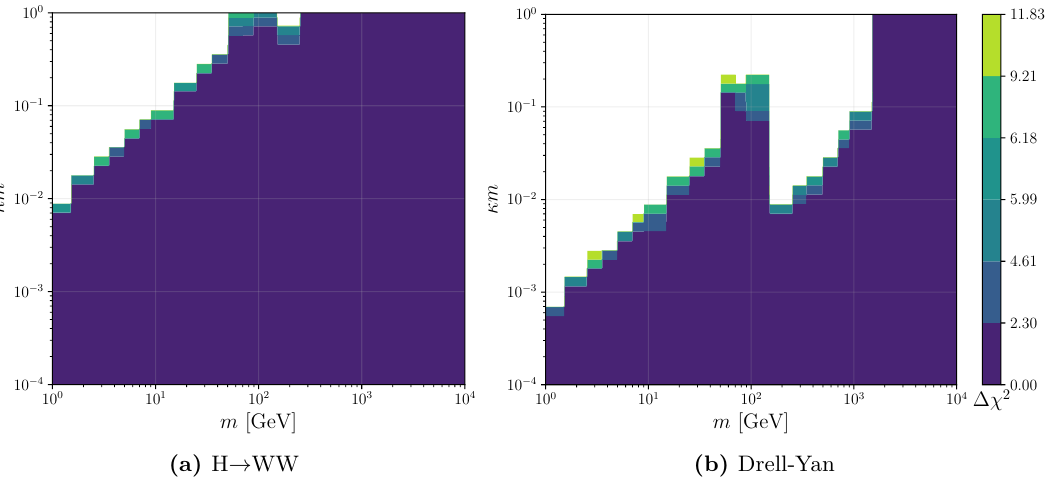
Figure 1. Density plots for the H → WW process in CMS (left) and Drell-Yan in ATLAS (right). The white region is excluded.